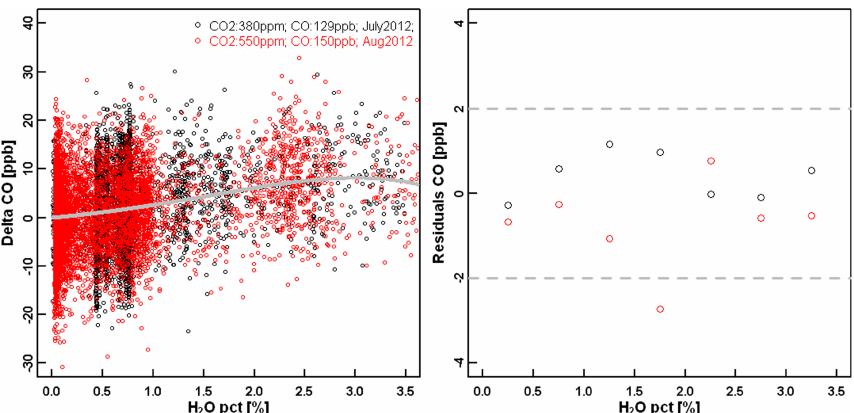
Fig. 4. Fourth-order fit of water droplet test data for analyzer with new fitting algorithm, 1 CO vs. H 2 O mole fractions for the range of 0–3.5%. The experimental data were weighted in the same way as for those presented in Fig. 3. The residuals from the fit are shown in the right figure, and dashed lines indicate the compatibility goals set by the WMO for CO measurements.The residuals from the fit for each water test, averaged over 0.5% H 2 O intervals, are shown in the right